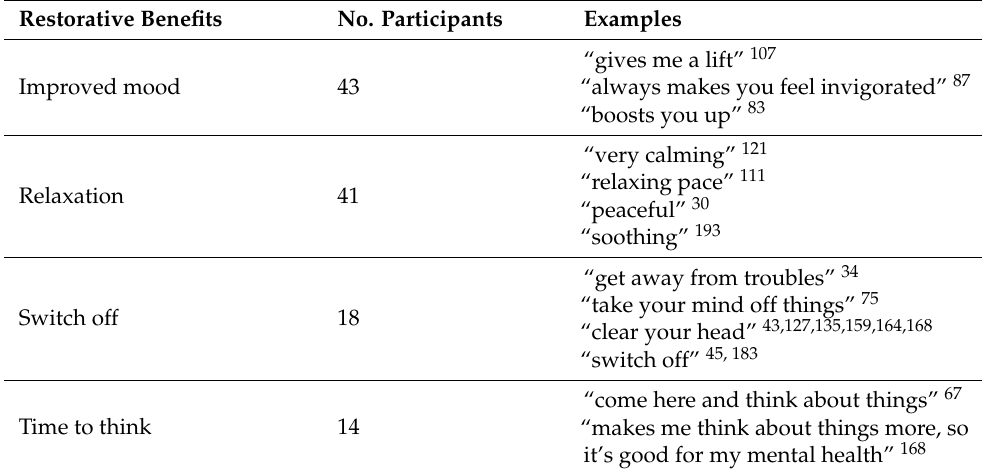
Table 1. Participant quotations on the restorative and mental health benefits of blue space. Restorative Benefits No. Participants